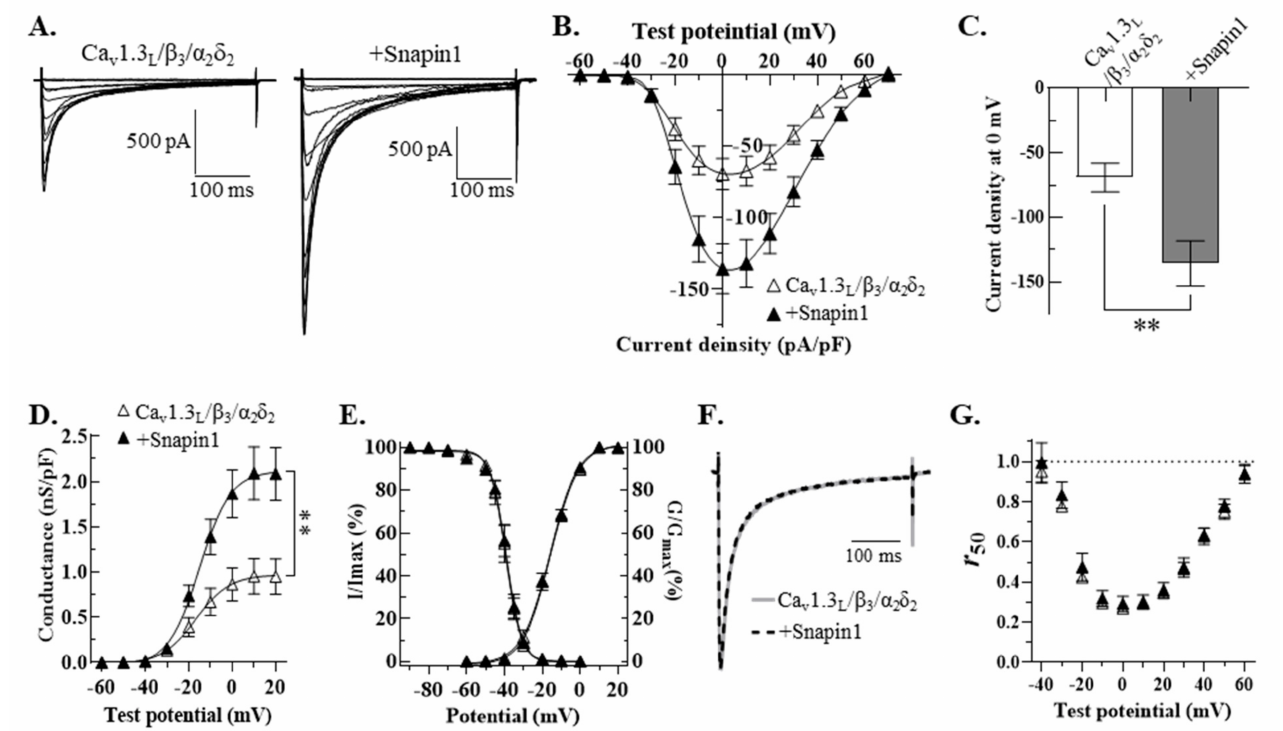
Figure 6. Up-regulation effect of Snapin1 variant on Ca v 1.3 L channels. ( A ) Ca v 1.3 L / β 3 / α 2 δ 2 without (left) or with (right) Snapin1 were co-expressed in HEK-293 cells. The same voltage protocols and analysis described in Figure 2 were used to characterize the biophysical properties of Ca v 1.3 L channels. ( B ) The I-V relationships of Ca v 1.3 L / β 3 / α 2 δ 2 co-expressed with ( (cid:78) ) or without ( ∆ ) Snapin1 (n = 8). ( C ) Snapin1 effect on the maximal current density of Ca v 1.3 L . The maximal current density values of Ca v 1.3 L without or with Snapin1 are − 69.2 ± 11.0 pA/pF and − 135.7 ± 17.6 pA/pF (n = 10; Student’s unpaired t -test, p < 0.01, **). ( D ) The chord conductance of Ca v 1.3 L channels without ( ∆ ) or with ( (cid:78) ) Snapin1. The maximal normalized conductance values of Ca v 1.3 L without or with Snapin1 are 0.95 ± 0.20 and 2.09 ± 0.29 nS/pF (n = 10; Student’s unpaired t -test, p < 0.01, **). ( E ) Channel availability and activation curves of Ca v 1.3 L channels without ( ∆ ) or with ( (cid:78) ) Snapin1 (n = 10). ( F , G ) No alteration in the CDI of Ca v 1.3 L by Snapin1. Ca 2+ current traces through Ca v 1.3 L channels without or with Snapin1 evoked at 0 mV test potential were superimposed. The r 50 values ( G ) of Ca v 1.3 L channels in the presence or absence of Snapin1 at various test potentials did not change the CDI of Ca v 1.3 L channels (n =